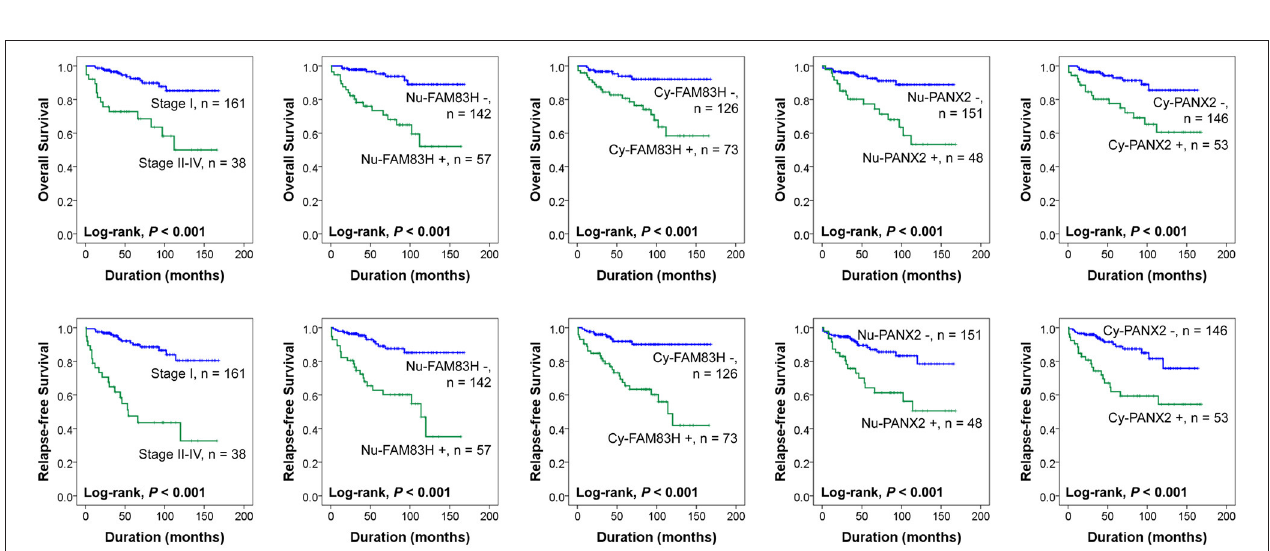
FIGURE 2 | Kaplan-Meier survival analysis of 199 clear cell renal cell carcinoma patients. Kaplan-Meier survival analysis for the overall survival and relapse-free survival according to the tumor stage, nuclear expression of FAM83H (Nu-FAM83H), cytoplasmic expression of FAM83H (Cy-FAM83H), nuclear expression of PANX2 (Nu-PANX2), and cytoplasmic expression of PANX2 (Cy-PANX2).